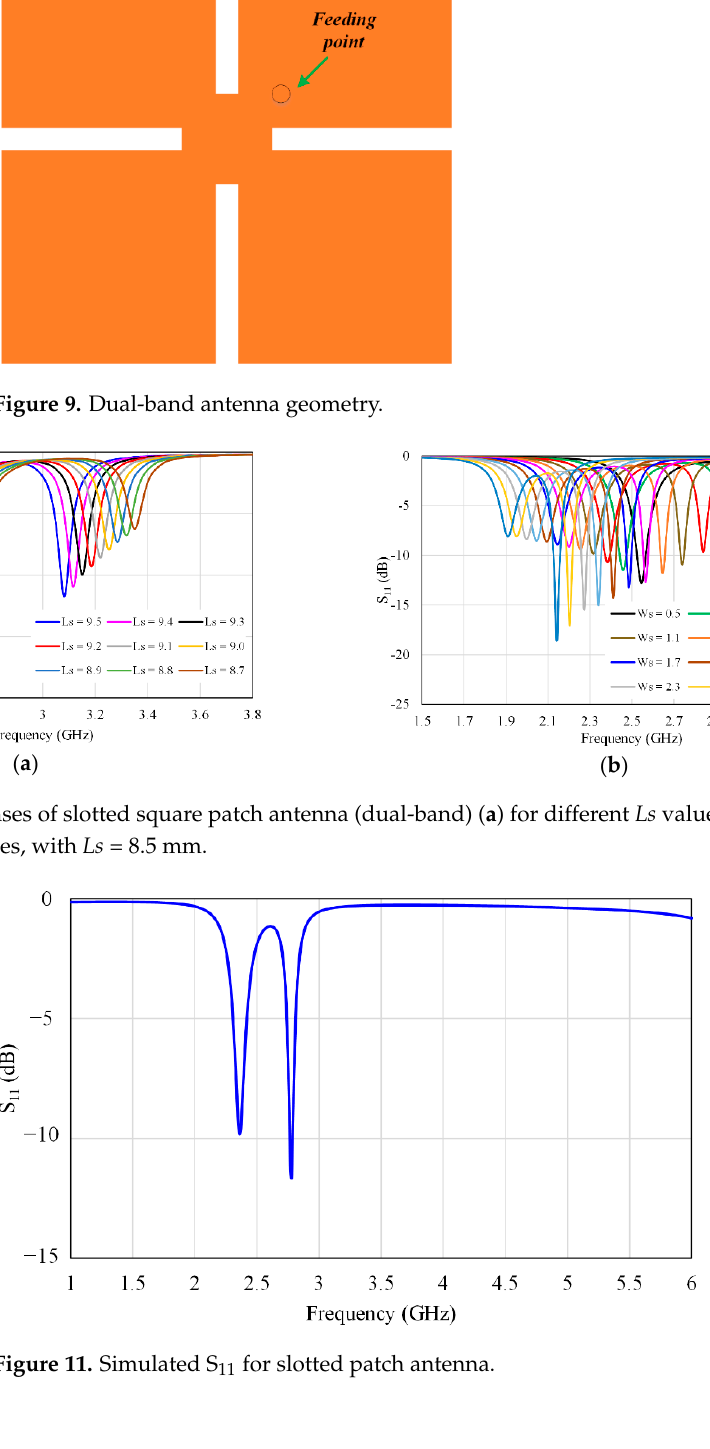
Figure 11. Simulated S 11 for slotted patch antenna.